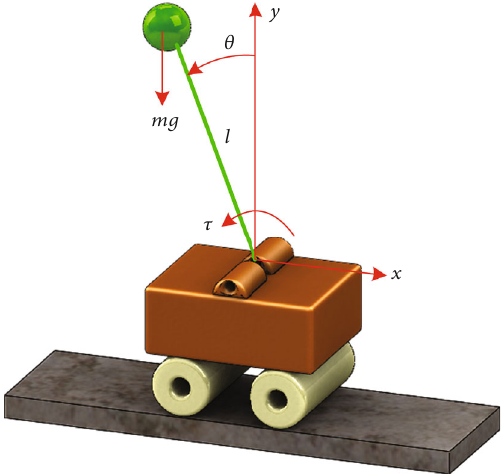
Figure 1: Inverted pendulum system.